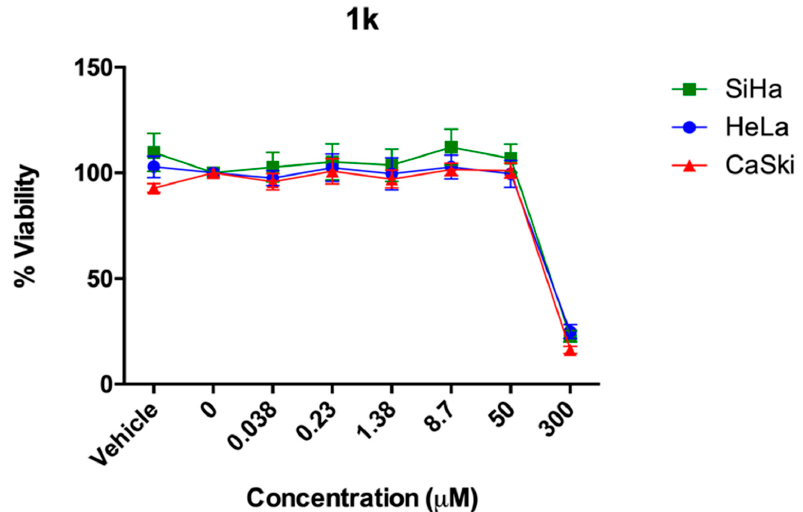
Figure 3. Cell viability of 1k on human cervical cancer cells SiHa, HeLa, and CaSki.